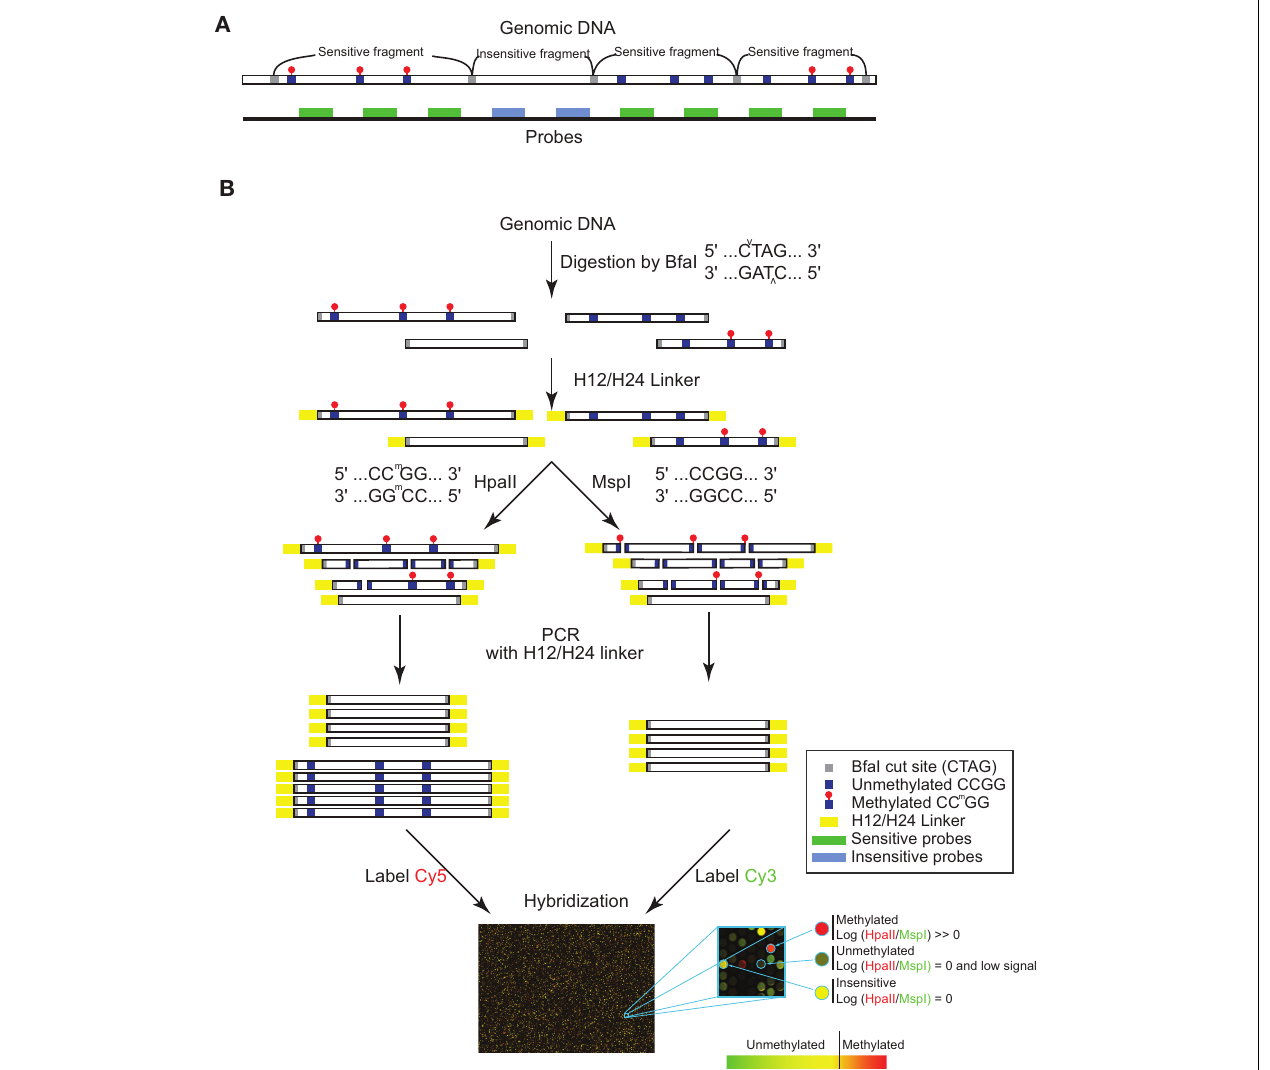
FIGURE 1 | Schematic diagram of in silico annotated genomic DNA and MSRE method. (A) Using in silico simulation, genomic DNA can be separated into MSRE sensitive and insensitive BfaI fragments (fl anked by gray boxes) based on the presence or absence of internal HpaII/MspI sites (CCGG) (blue squares). Microarray probes binding to sensitive fragments are represented with green rectangles. Probes binding to insensitive fragments are represented by blue rectangles. Sensitive fragments can have multiple CCGG sites that can be fully methylated, partially methylated, or completely unmethylated in tandem. Methylated CCGG sites (CC m GG) are indicated with a red dot placed above the blue square. (B) Genomic DNA is fragmented with BfaI, ligated to H12/H24